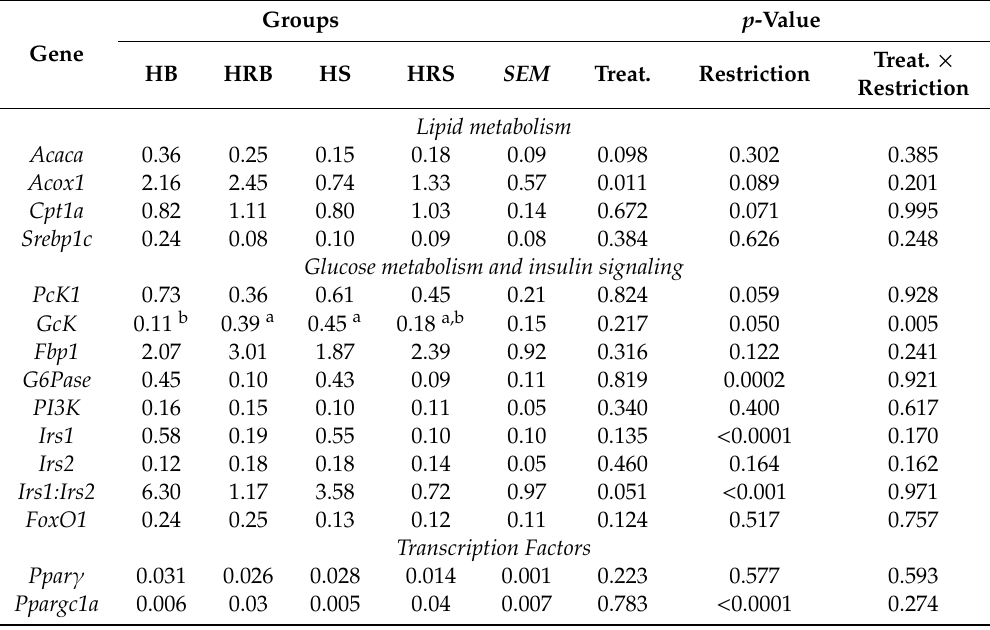
Table 2. Hepatic mRNA relative expression of mice fed hypercaloric diet, treated with butaphosphan or saline solution, and submitted or not to food restriction (Experiment